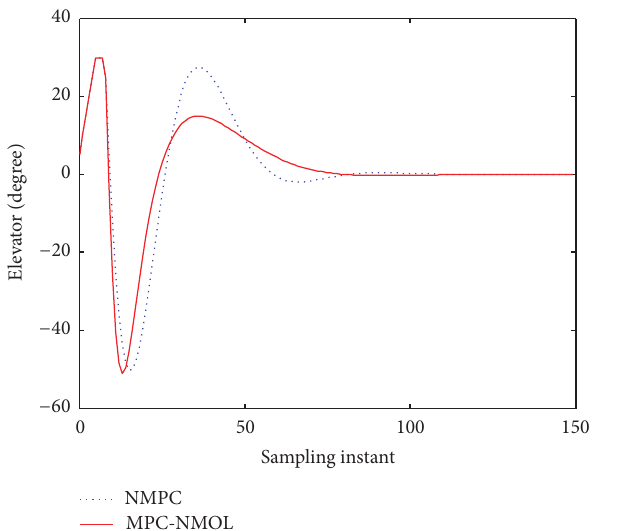
Figure 6: Comparison of elevator deflection angle with no distur- bance.